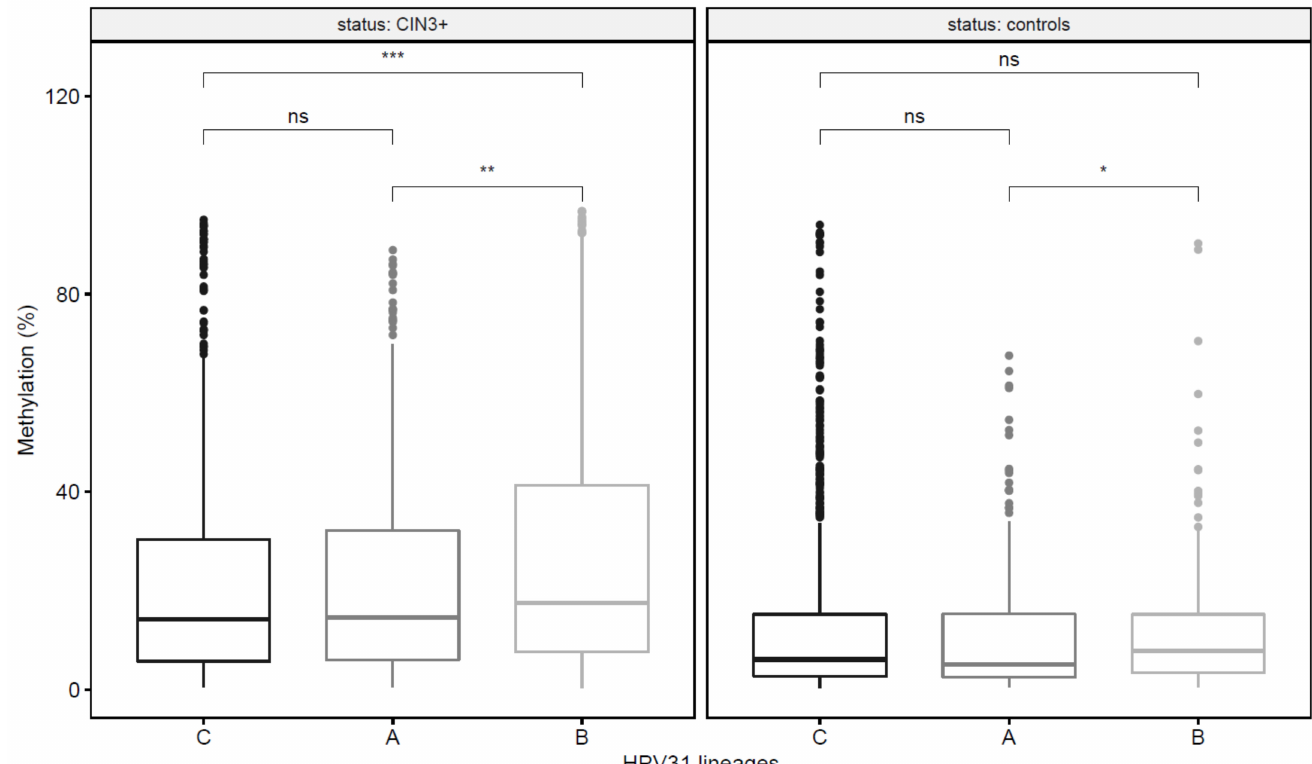
Figure 3. Viral methylation levels across all CpG sites tested by HPV31 lineages C, A and B, shown for CIN3+ cases and controls. The y -axis represents the percent methylation levels. x -axis represents each individual lineage. Footnote: p -values from Mann–Whitney (Wilcoxon Rank Sum) test. ns = non-significant; *** = p < 0.001; ** = p < 0.01; * = p < 0.05. Table 3. Top CpG sites with high methylation associated with CIN3+ for each HPV31 lineage in the PaP Cohort. Gene Lineage CpG Site †